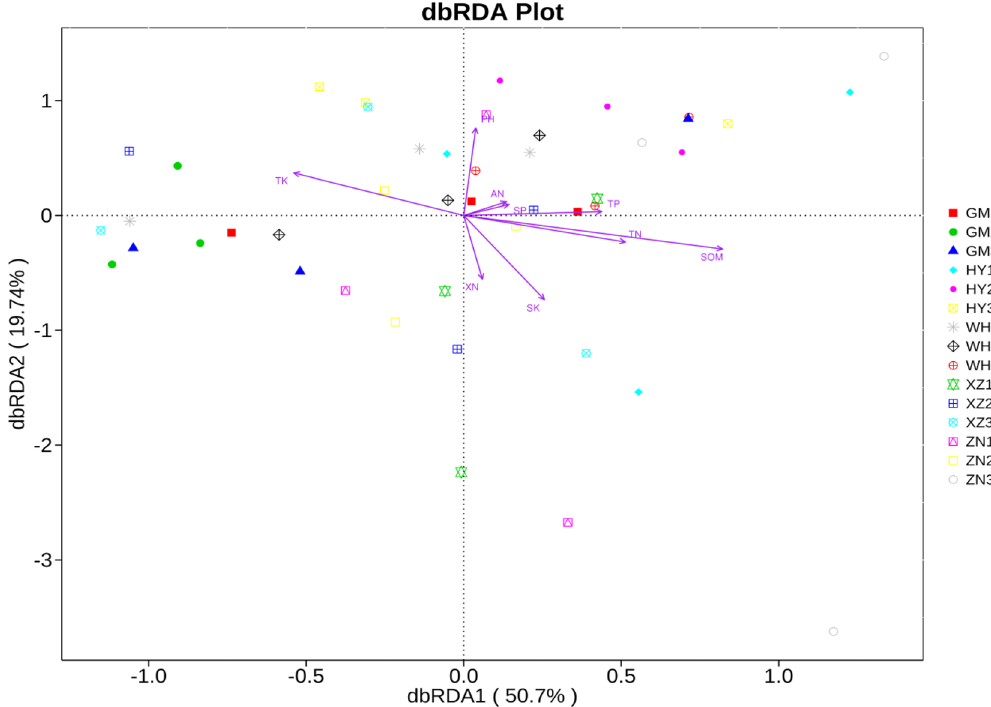
Figure 4. Redundancy analysis of soil physicochemical indices and fungal phyla. The abbreviations ZN, XZ, HY, WH, GM represent the grape planting years of 5, 8, 10, 12 and 15, respectively; and the numbers 1, 2 and 3 represent the rhizosphere soil depths of 5–20, 20–35 and 35–50 cm,